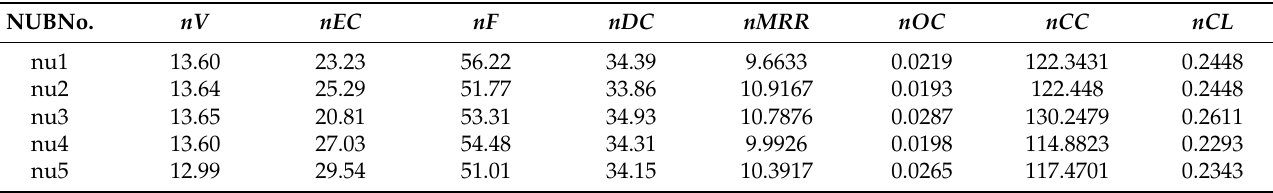
Table A14. New food by unemployed bees ( NueNo.